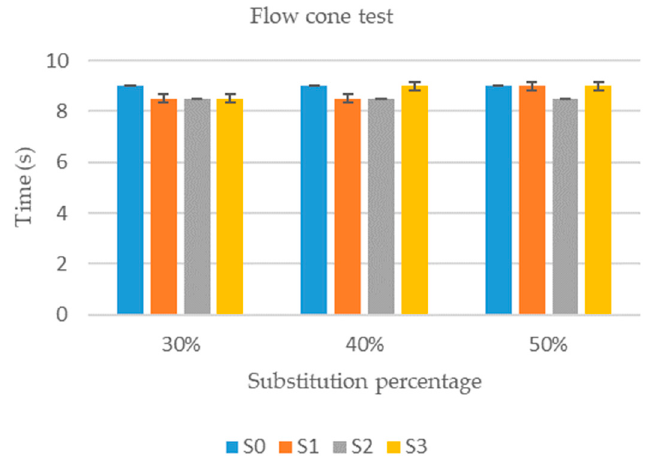
Figure 3. Flow cone test results.